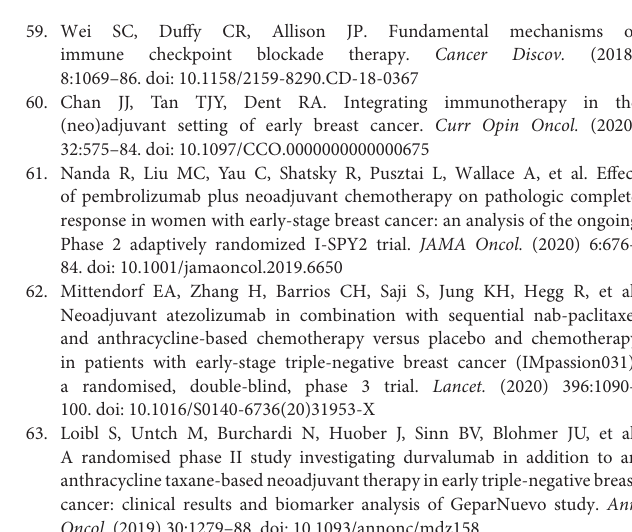
cancer: clinical results and biomarker analysis of GeparNuevo study. Ann Oncol. (2019) 30:1279–88. doi: 10.1093/annonc/mdz158 Conflict of Interest: The authors declare that the research was conducted in the absence of any commercial or financial relationships that could be construed as a potential conflict of